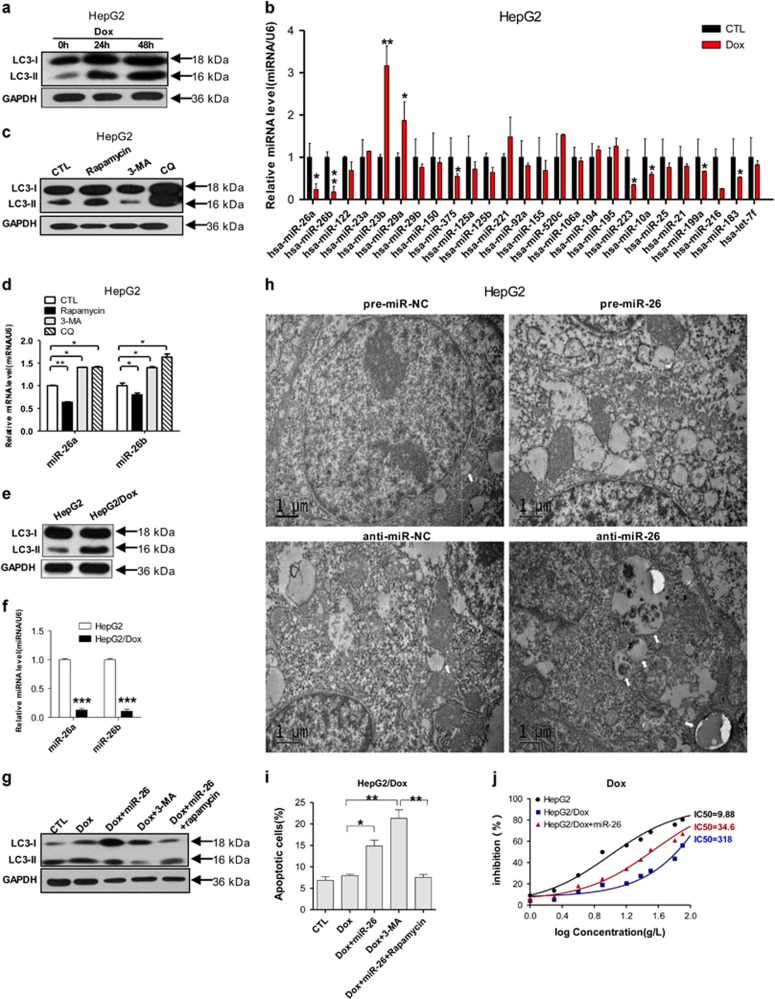
Dox-induced autophagy decreases miR-26a/b levels, and miR-26a/b promotes apoptosis and inhibits viability and proliferation of HCC cells through downregulating autophagy. (a) Representative western blotting analyses of LC3-I and LC3-II in HepG2 cells after treatment with Dox for 24 and 48 h. (b) Relative levels of miRNAs in HepG2 cells after treatment with Dox for 48 h were analyzed using RT-qPCR. (c) Representative western blotting analyses of LC3-I and LC3-II in HepG2 cells after treatment with or without rapamycin, 3-MA and CQ for 24 h. (d) miR-26a/b were detected using RT-qPCR in HepG2 cells after treatment with/without 3-MA, CQ and Rapamycin for 24 h. (e) Protein levels of LC3-I and LC3-II in HepG2 and HepG2/Dox cells. (f) Relative miR-26a/b levels in HepG2, HepG2/Dox cells. (g) Representative western blotting analyses of LC3-I and LC3-II in HepG2/Dox cells transfected with/without miR-26a/b mimics under different treatments for 24 h. (h) The ultrastructure of treated HepG2 cells were observed by electron micrography after 24-h transfection. White arrows showed autophagosomes or autophagosome-fused lysosomes. (i) Apoptosis of HepG2/Dox cells transfected with or without miR-26a/b mimics under various treatments were analyzed. (j) The sensitivities of HepG2 and HepG2/Dox cells under different treatments were determined using a CCK-8 assay. Statistical data are presented as the means±S.E. from three independent experiments. *P<0.05; **P<0.01; and ***P<0.001